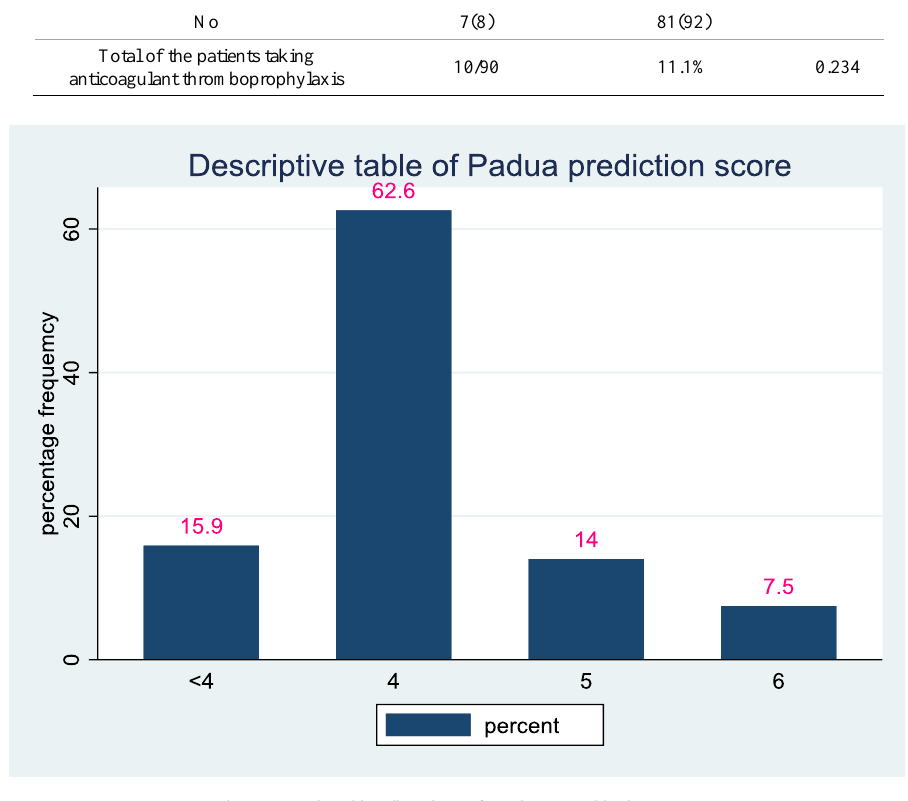
Figure 1. The distribution of Padua prediction score